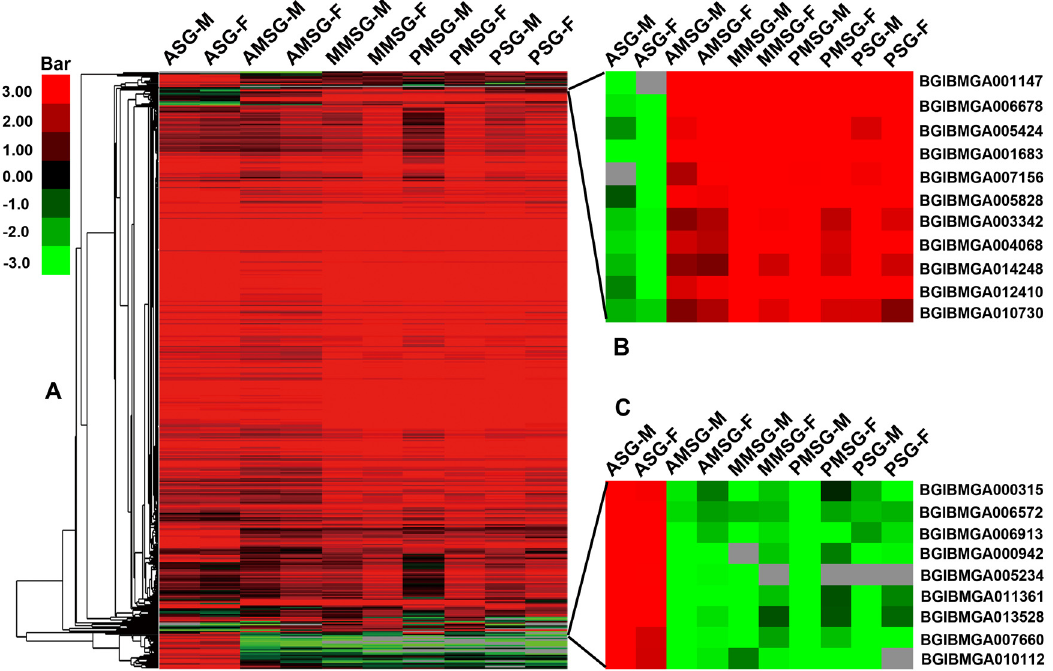
Fig 1. Hierarchical clustering of the expressed genes in different parts. (A) The expression profile of all expressed genes in the silk gland. (B) The expression profile of some genes with down-regulated expression in the ASG. (C) The expression profile of some genes with up-regulated expression in the ASG. The RNA-Seq data for clustering derived from the different parts of the silk gland based on RPKM values. The red bands indicate genes with high expression levels and the green bands indicate genes with low expression levels.